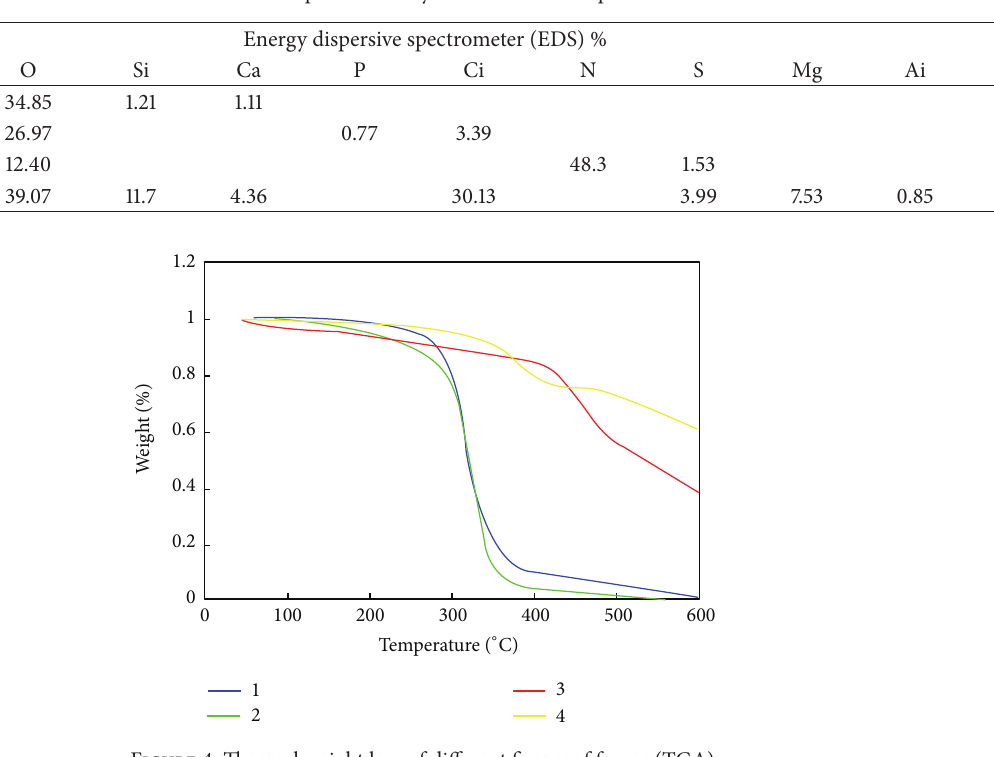
Table 3: EDS composition analysis on different fireproof foams.